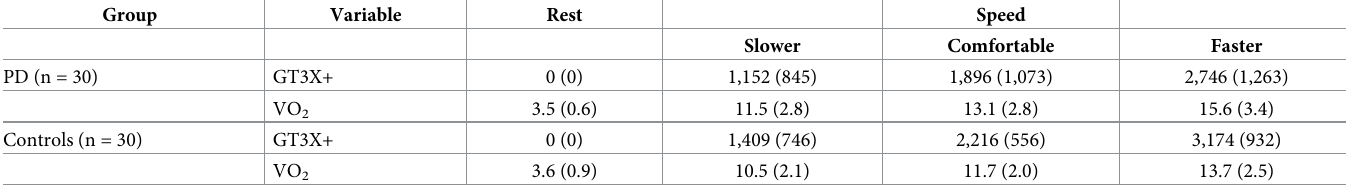
Table 3. Accelerometer (ActiGraph GT3X+) and metabolic (rate of oxygen consumption [VO 2 ]) data for rest and three treadmill walking speeds in persons with Parkinson’s Disease (PD) and controls.